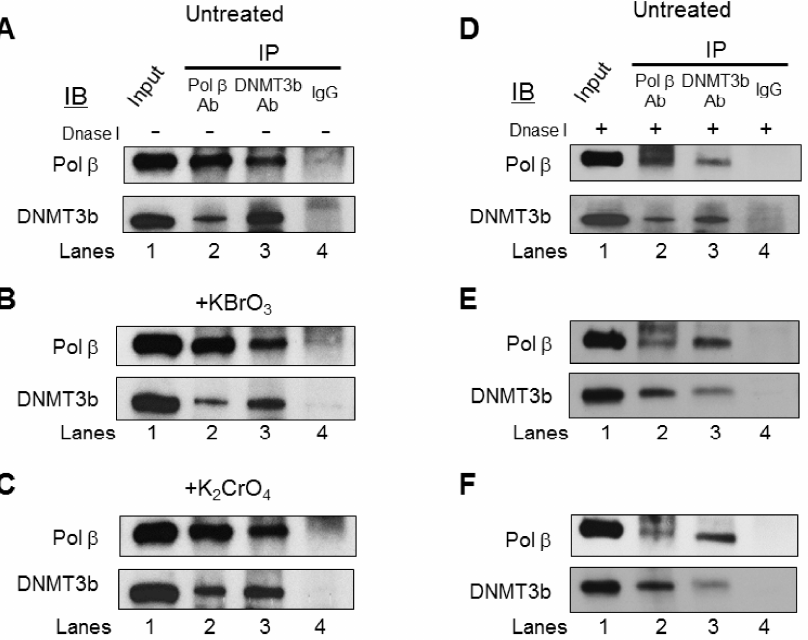
Figure 5. Pol β interacts with DNMT3b in cells. Co-IP and immunoblotting (IB) of pol β or